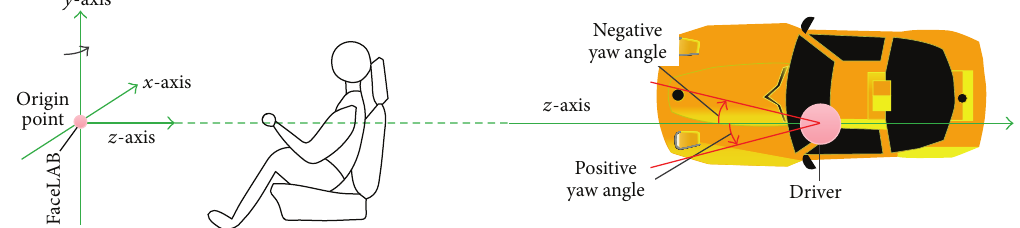
Figure 1: The car-fixed coordinate system for the driver’s eye